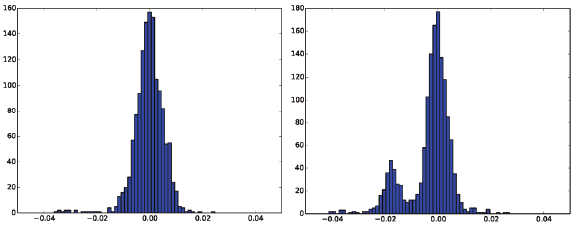
Figure 13. Histogram of deviations between -5 cm and +5 cm after adjustment for scanner 1 (left) and 2 (right). Figure 11. Colour coded deviations between reference and point cloud after adjustment of the trajectory for scanner 1 (left) and scanner 2 (right) with red = +5 cm, green = 0 cm, blue = -5 cm, magenta: detected outliers.